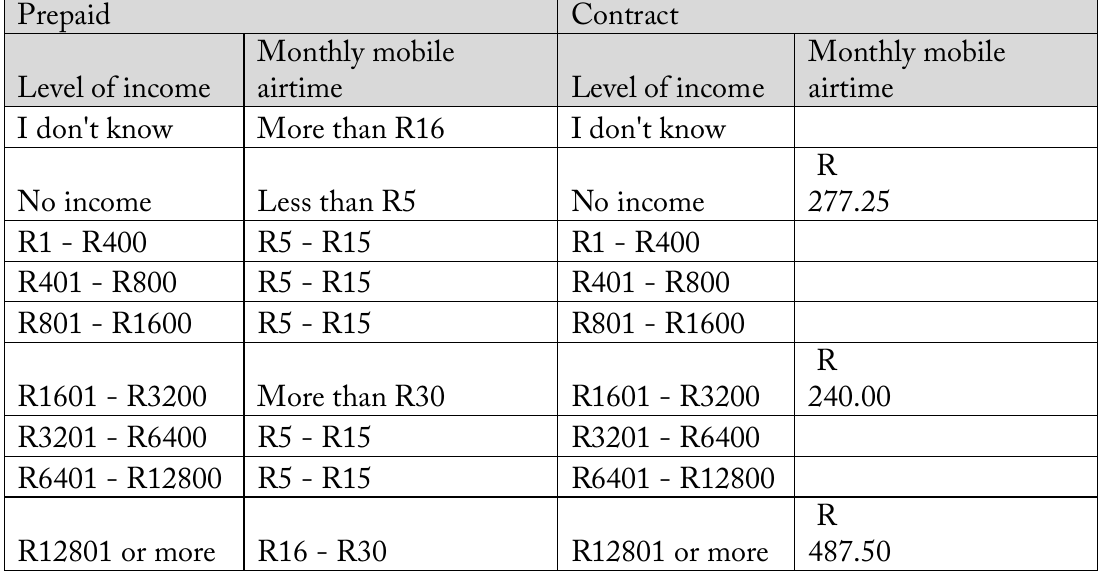
Table 2: Monthly income verses expenditure on mobile airtime